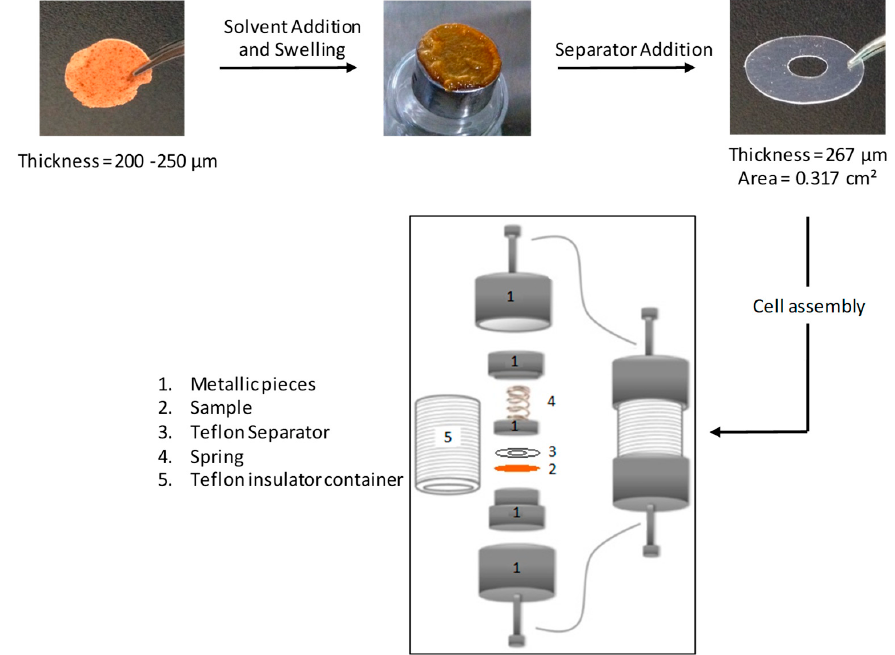
Figure 1. Sample preparation and Swagelok cell assembly for electrochemical impedance spectroscopy (EIS) measurements.